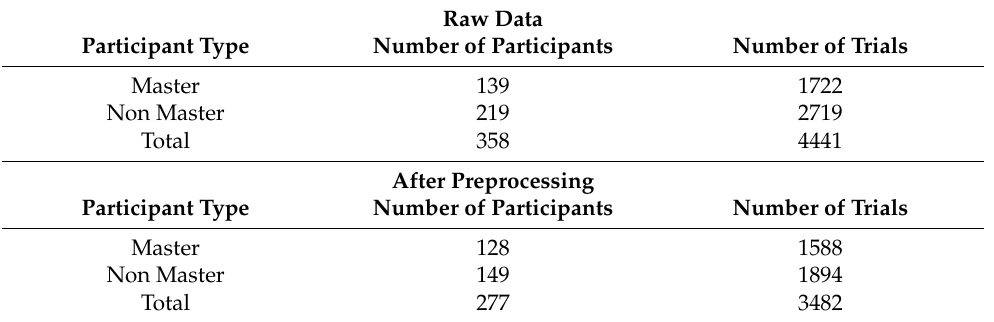
Table 2. Overview of the participants and trials in